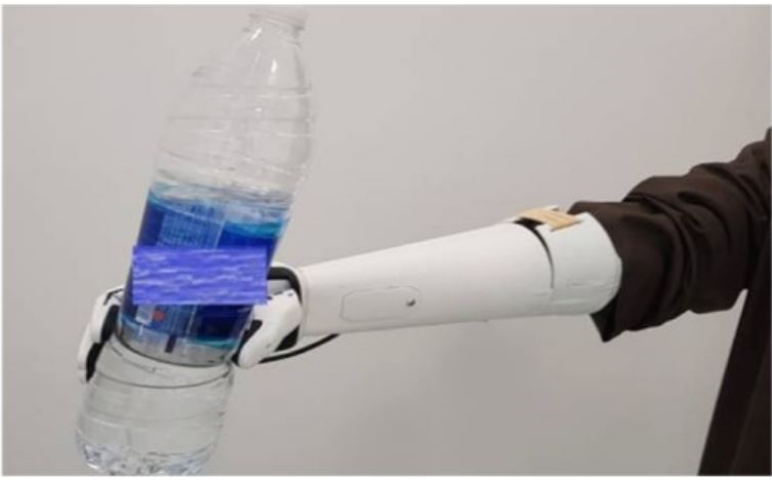
Figure 5. Bionic arm load